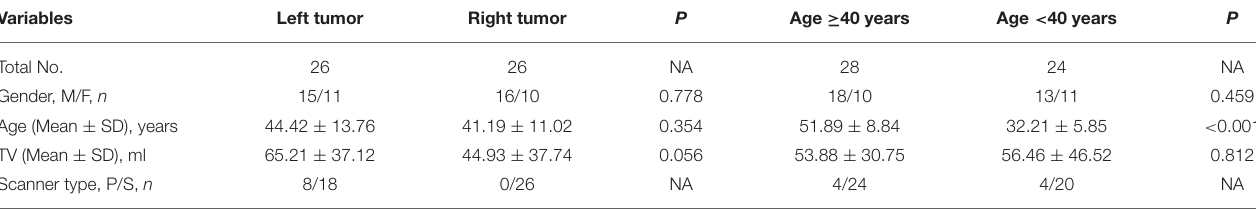
TABLE 2 | Demographic characteristic of different tumor sides and